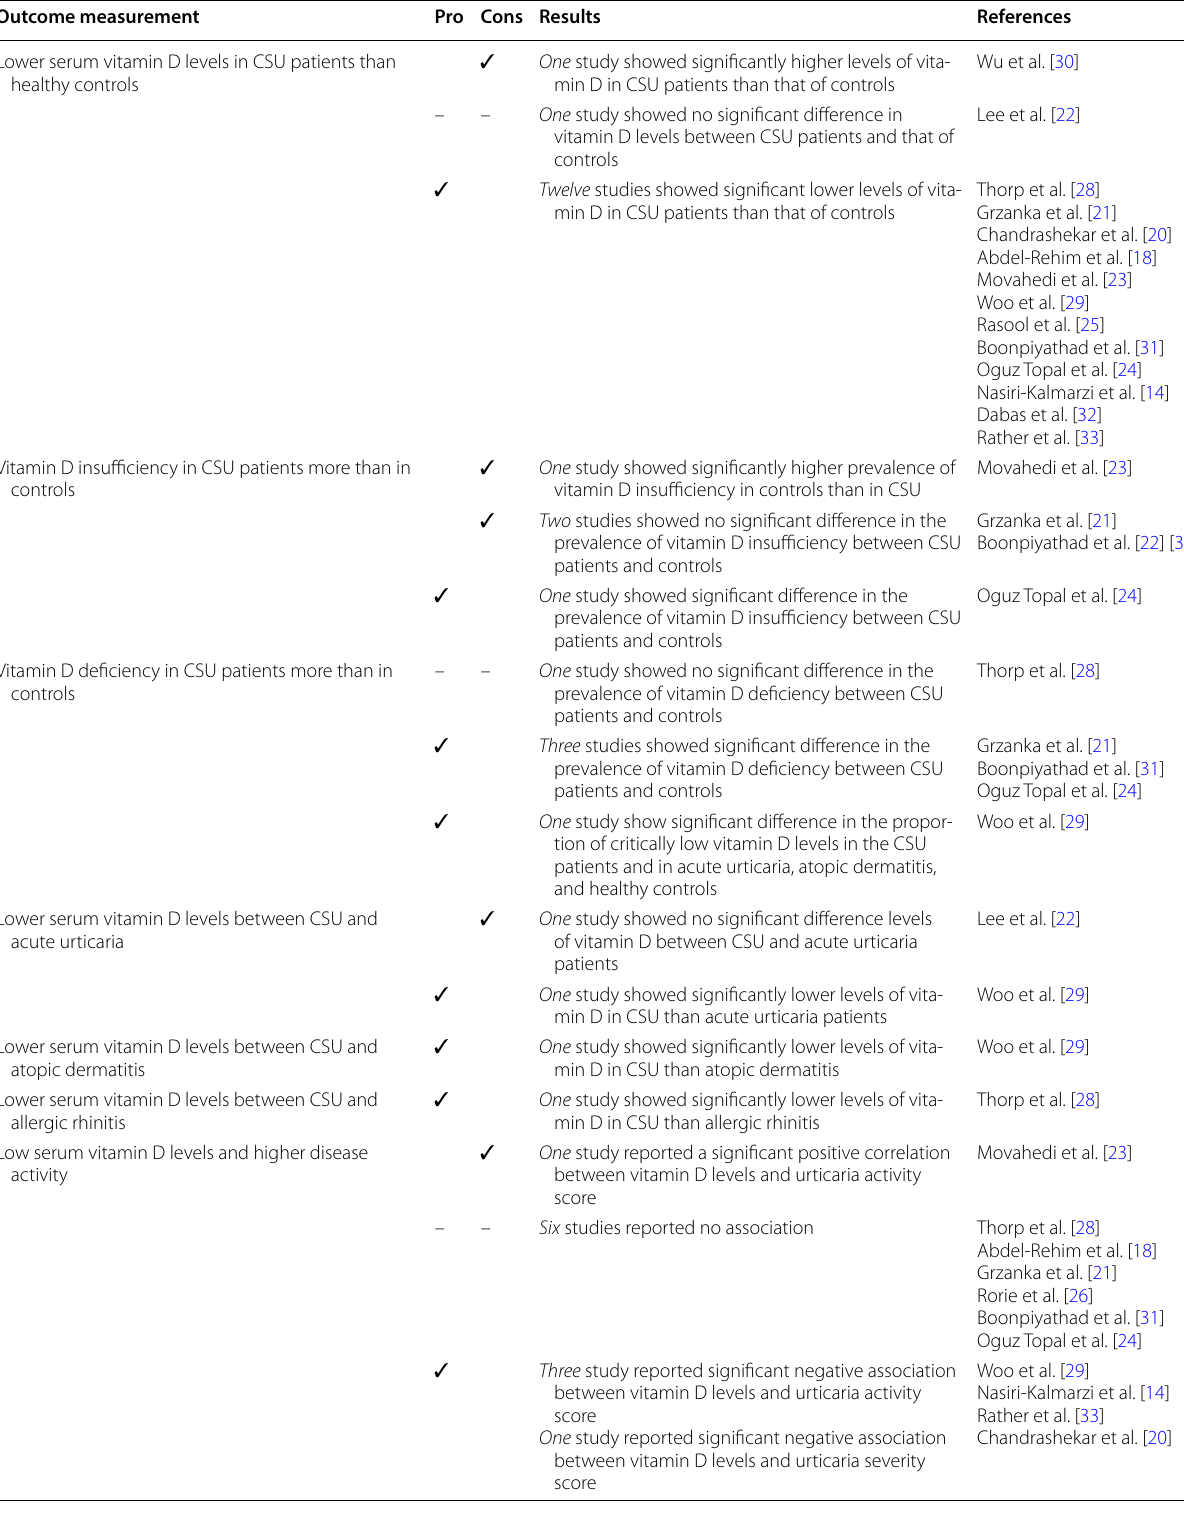
Table 2 Summary of parameters of vitamin D in CSU Outcome measurement Pro Cons